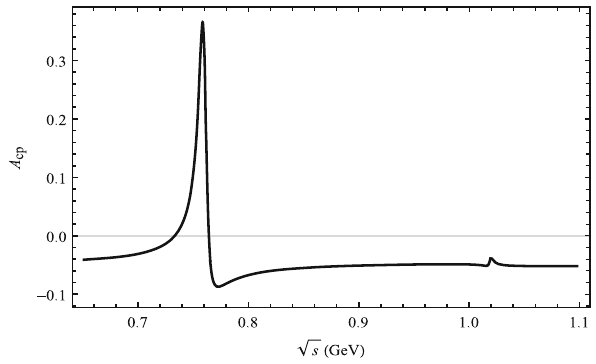
√ s corresponding to central